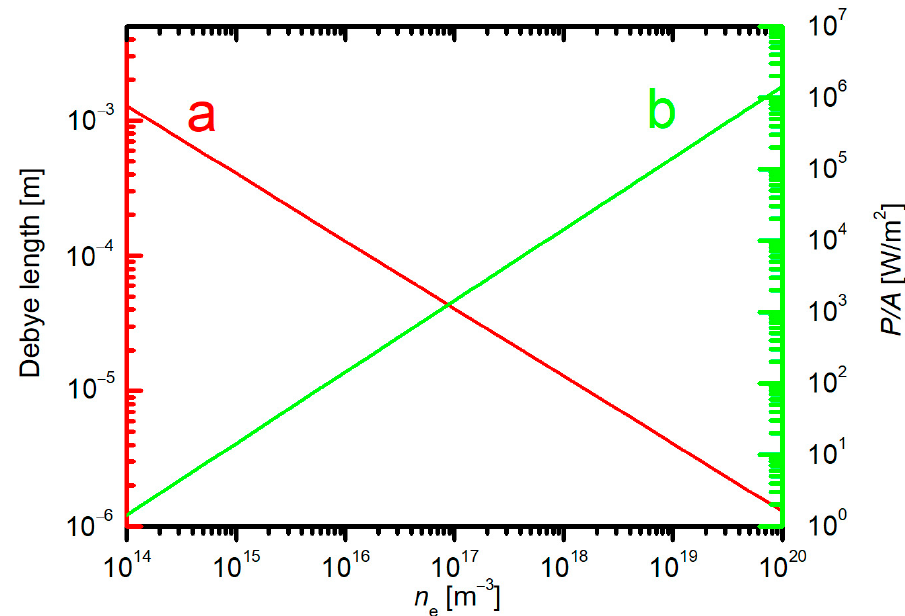
Figure 7. The Debye length (a) and the power dissipated on a surface facing a continuous plasma (b) versus the electron density at kT e = 3 eV.